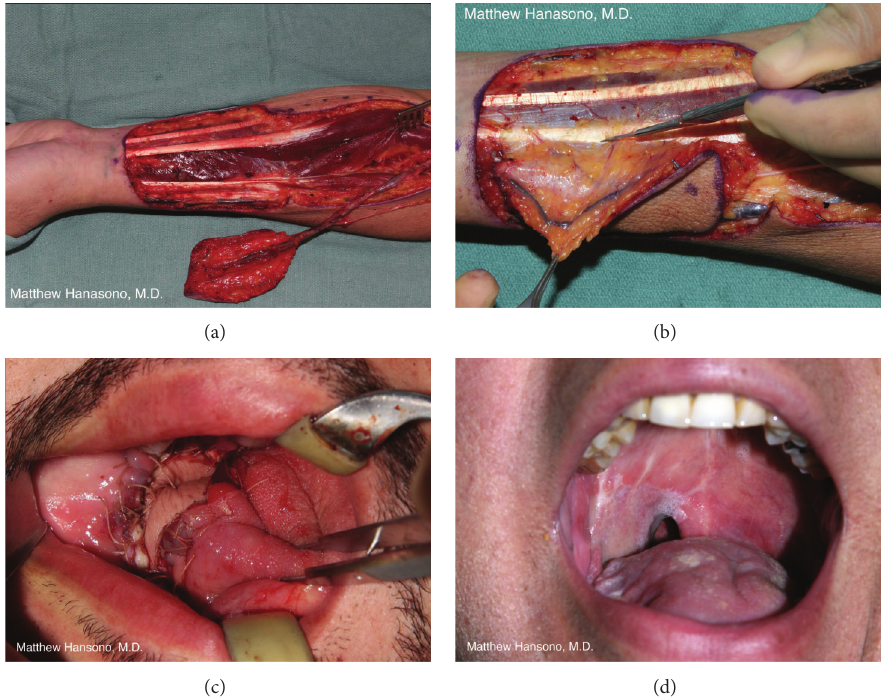
Figure 10: Radial forearm free flap harvest for a right oropharyngeal defect (a). To minimize donor site morbidity, a suprafascial harvest technique is used (b). Flap inset (c). Postoperative appearance demonstrating excellent mouth opening (d).